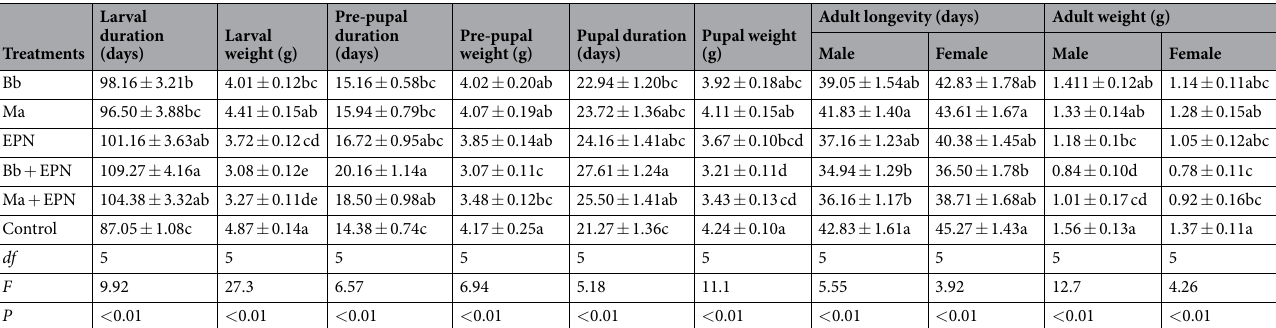
Table 6. Effect of Beauveria bassiana (1 × 10 4 spore ml − 1 ) , Metarhizium anisopliae (1 × 10 4 spore ml − 1 ) and Heterorhabditis bacteriophora (50 IJs ml − 1 ) on the development of Rhynchophorus ferrugineus . Mean sharing